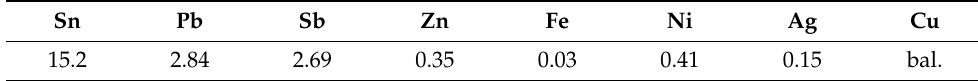
Table 1. Chemical composition of the Maryan bell (wt.